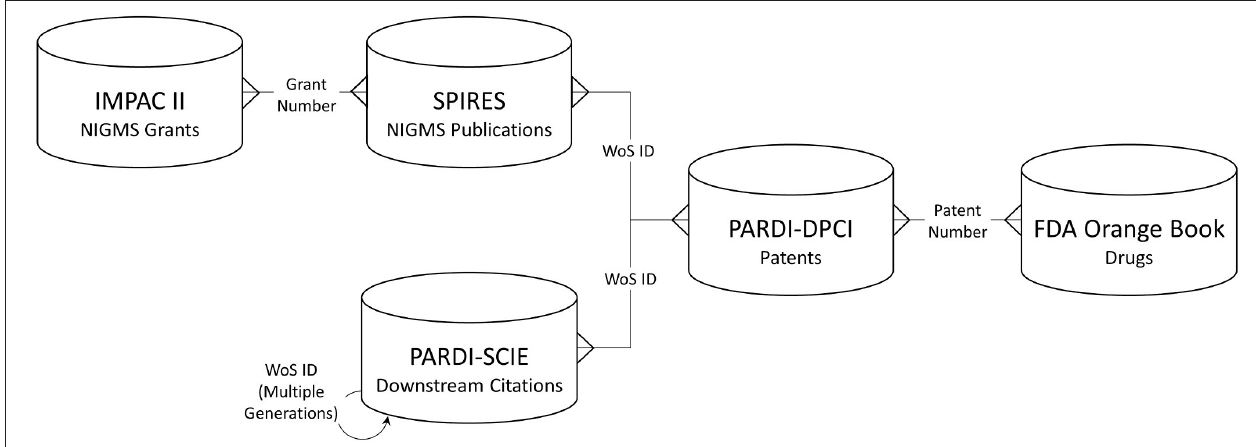
FIGURE 1 | Databases used and linkage keys. IMPAC II, NIH Information for Management Planning Analysis and Coordination; SPIRES, NIH Scientific Publication Information Retrieval and Evaluation System; PARDI-SCIE, Clarivate Science Citation Index Expanded, included in the NIH Portfolio Analysis and Reporting Data